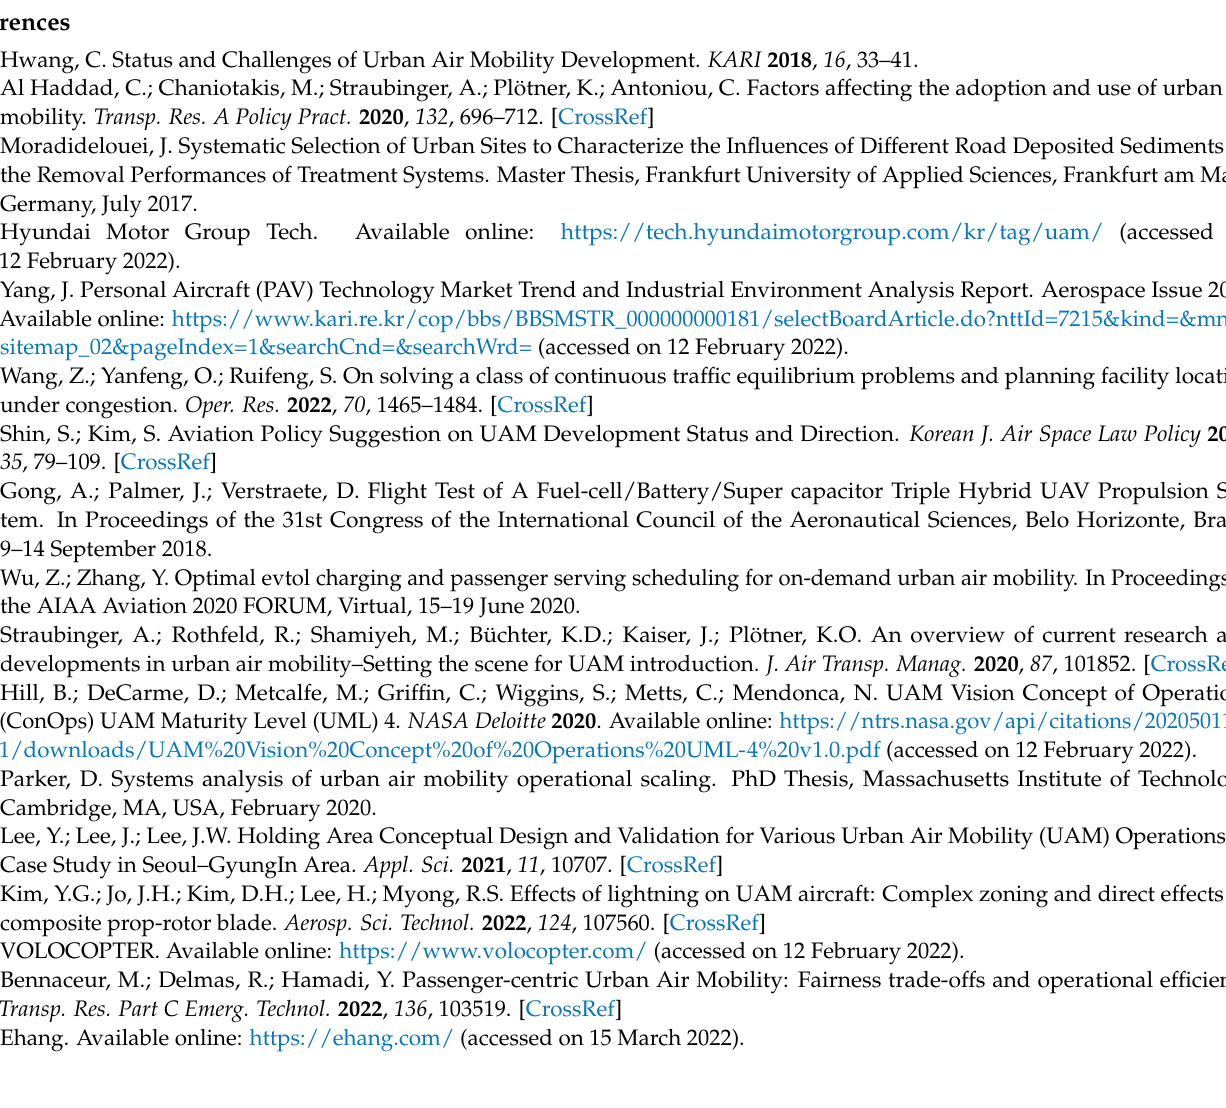
Figure A5. Network analysis by technology.